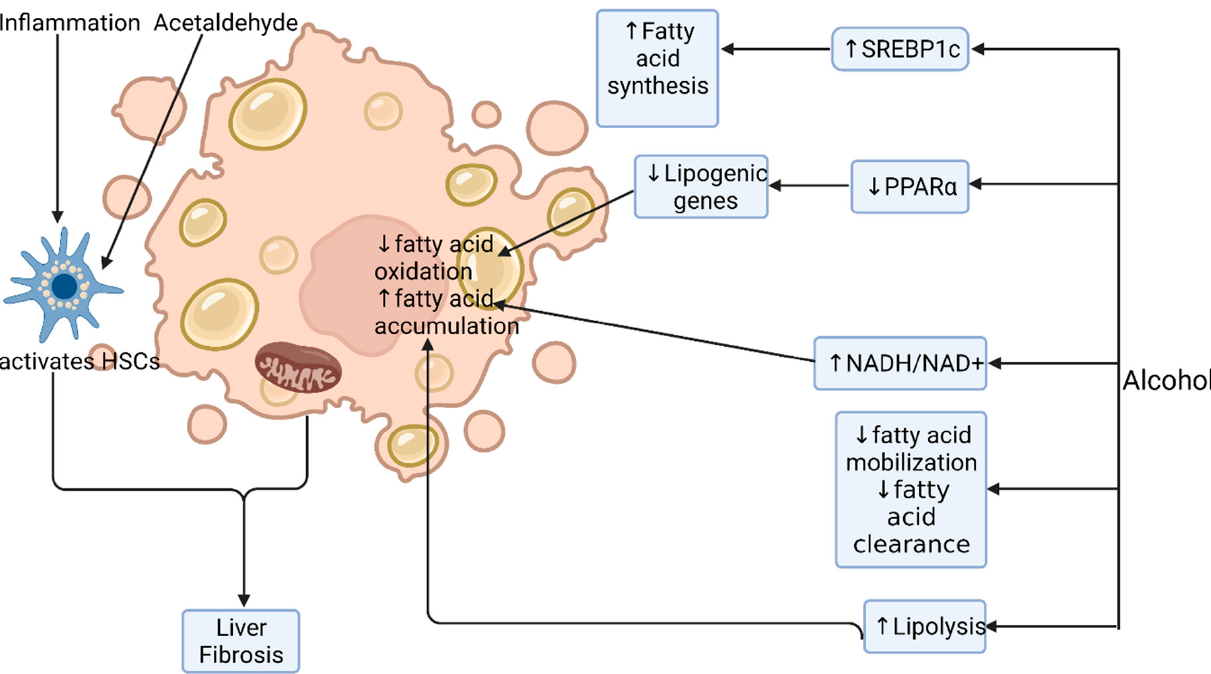
Figure 3. Alcohol-induced steatosis. Alcohol induces hepatic steatosis by multiple mechanisms. It alters the redox ratio in the cell (NADH/NAD+), thereby inhibiting fatty acid oxidation and promoting its accumulation. It increases transcription factor SREBP1c, which leads to increased fatty acid synthesis and deposition. Alcohol inactivates PPAR α , a nuclear hormone receptor that regulates many of the genes involved in fatty acid transport and oxidation. Alcohol has a direct inhibitory effect on fatty acid clearance and mobilisation. ↑ : increased; ↓ : decreased; HSC: hepatic stellate cell. Image created at biorender.com (accessed on 20 August